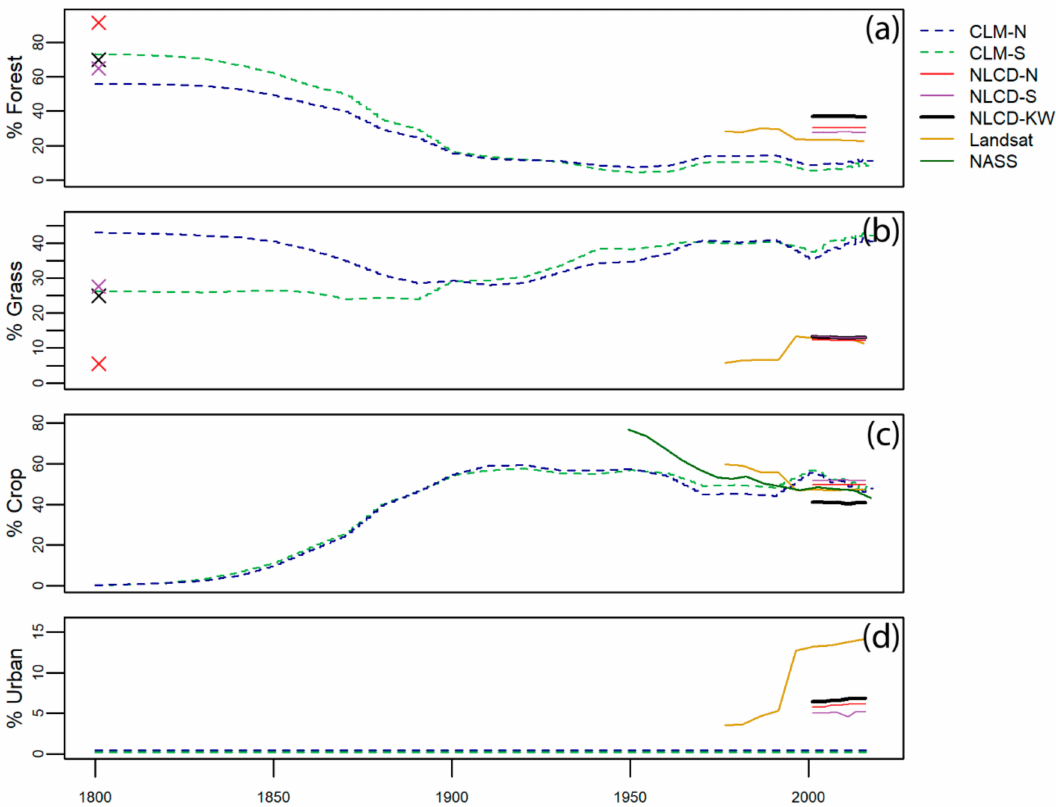
Figure 5. Long term comparison of landcover in CLM to available data (note varying y-axes). The 1800 map vegetation data for forest and grass are represented by an “x” at 1800 with colors corresponding to the two CLM grid cells as above and black for the KW. Plots show forest ( a ); grasslands ( b ); croplands ( c ); and urban areas ( d ). NLCD is the Landsat derived National